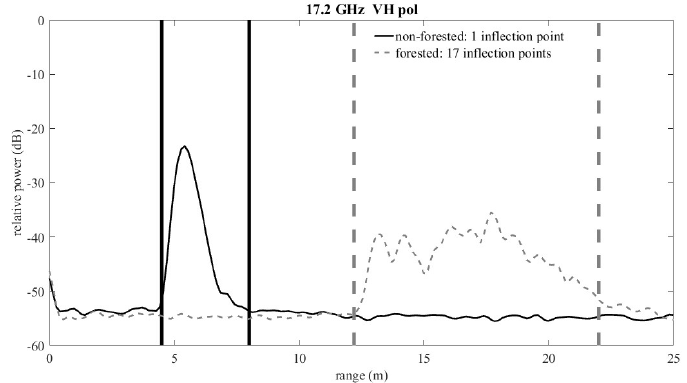
Figure 5. Typical range profiles of non-forested ( left ) and forested sites ( right ). Vertical bars bound target profiles, between which inflection points were tallied.